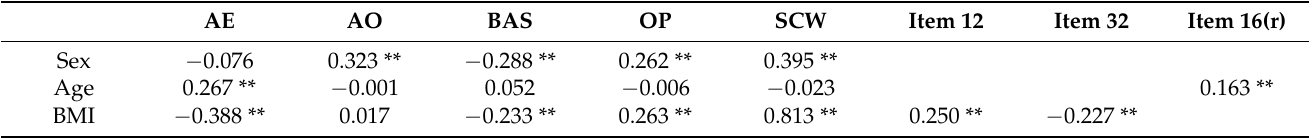
Table 5. Standardized